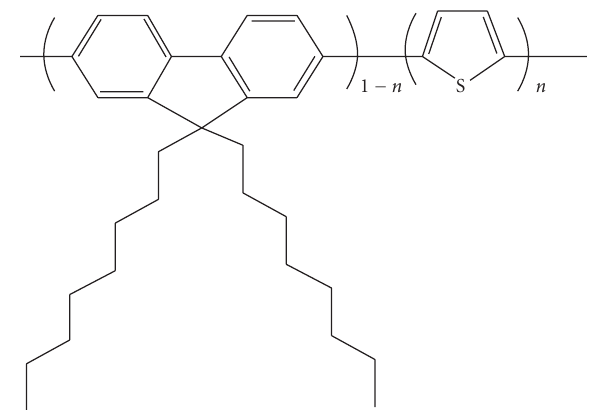
Figure 1: Structure of conjugated polymer poly(fluorene-co- thiophene).